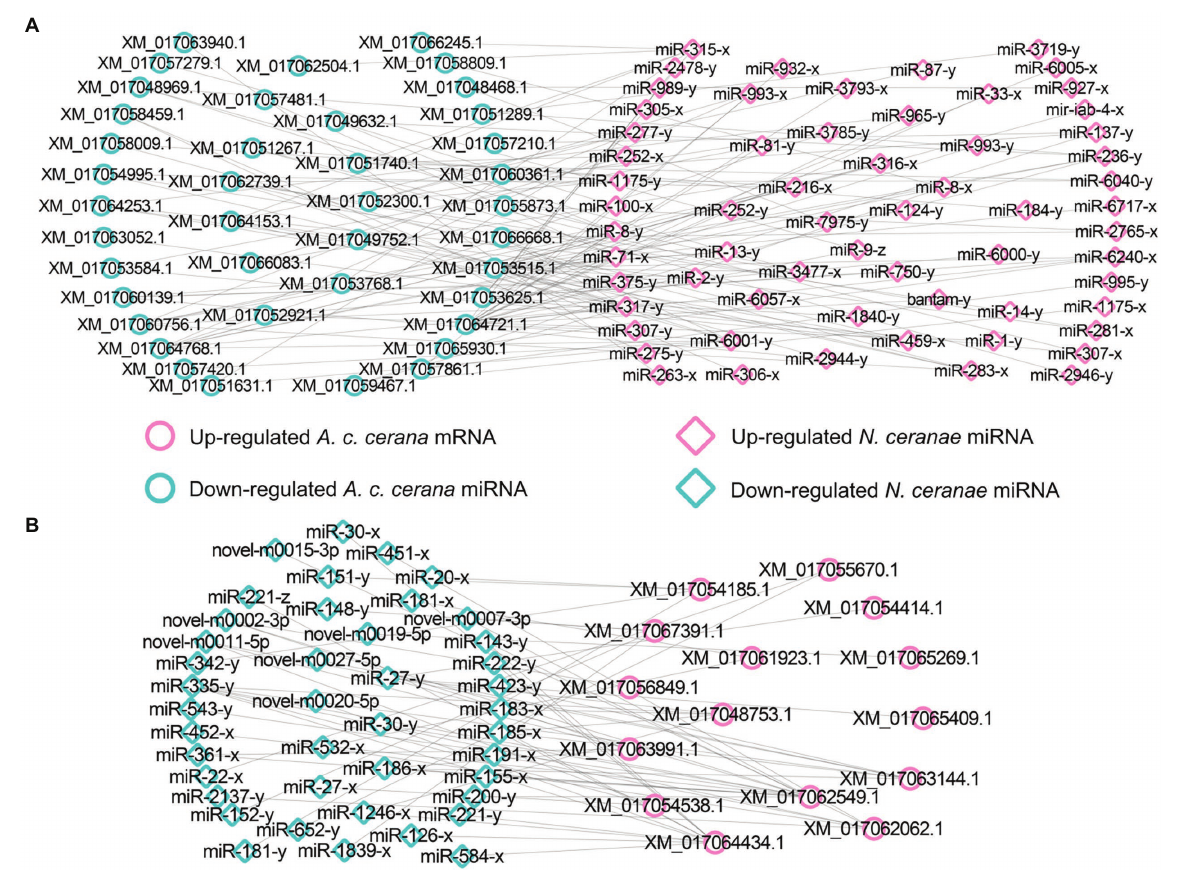
FIGURE 7 Regulatory networks of DEmiRNAs shared by NcCKmi vs. NcTmi7 and NcCKmi vs. NcTmi10 comparison groups and their targeted DEmRNAs shared by AcCKm7 vs. AcTm7 and AcCKm10 vs. AcTm10 comparison groups. (A) Network of common up-regulated miRNAs in microsporidian and common down-regulated mRNAs in host. (B) Network of shared down-regulated miRNAs in microsporidian and common up-regulated mRNAs in